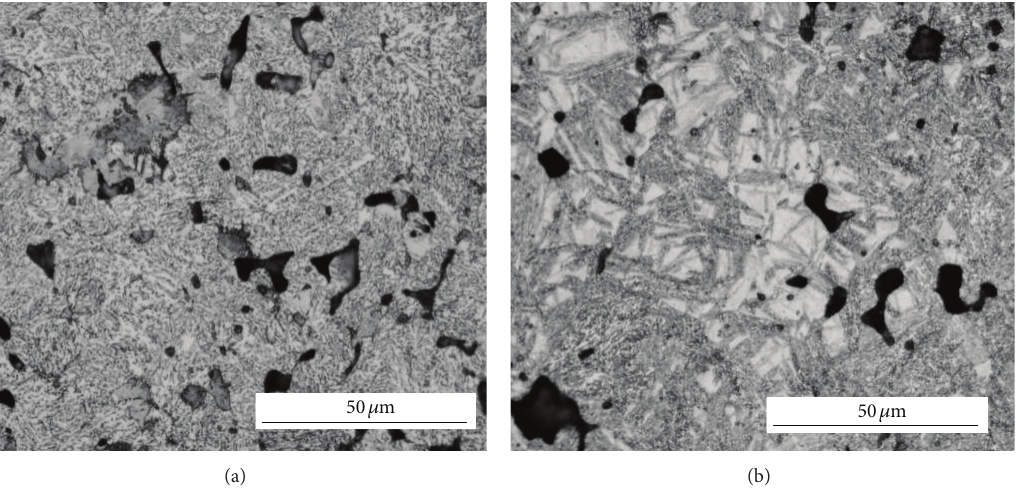
Figure 11: Microstructure of the AstCrM + 0.5% C components sintered at 1200 ∘ C for 30min (a) prevalent upper bainitic when cooled at 10 ∘ C/min and upper/lower bainite mixture when cooled at 50 ∘ C/min.